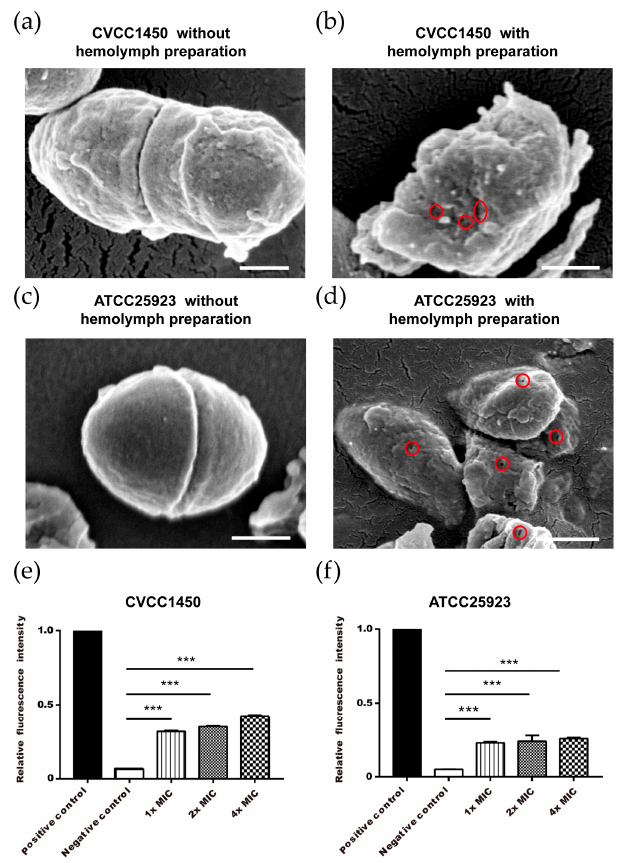
Figure 3. Bacterial membrane permeabilization induced by Z. morio hemolymph. ( a , b ) E. coli CVCC1450 (10 8 CFU / mL) were incubated at 37 ◦ C for 30 min with or without Z. morio hemolymph (1 mg / mL). Red circles indicate rupture of the cell wall integrity. Scale bars indicate 250 nm. ( c , d ) S. aureus ATCC25923 (10 8 CFU / mL) were incubated at 37 ◦ C for 30 min with or without Z. morio hemolymph (1 mg / mL). Red circles indicate rupture of the cell wall integrity. Scale bars indicate 250 nm. E. coli CVCC1450 ( e ) and S. aureus ATCC25923 ( f ) were treated with various concentrations of Z. morio hemolymph and incubated for 1 h at 37 ◦ C followed by propidium iodide (PI) staining. Ultrasonic cracking lysed bacterial samples were used as a positive control and intact bacterial suspensions were used as a negative control. The blank control was similar to the negative control, except for no bacteria. Results were expressed as relative fluorescence intensity (RFI). RFI = (OD value of sample − OD value of blank control) / (OD value of positive control − OD value of blank control). Three experiments were carried out in duplicate and the results are expressed as the mean ± SD. *** p < 0.001.